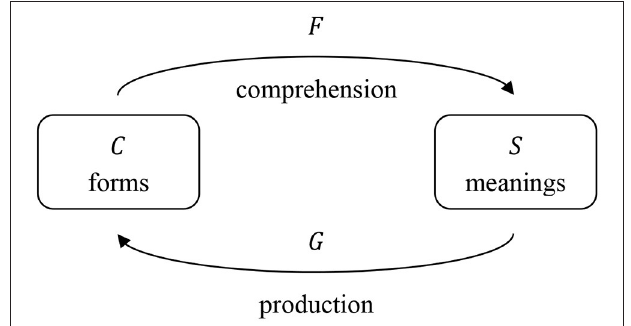
FIGURE 1 | Comprehension and production mapping, adapted from Baayen et al. (2019b). For comprehension, transformation matrix F transforms the cue matrix C into the semantic matrix S . For production, transformation matrix G transforms the semantic matrix S into the cue matrix C